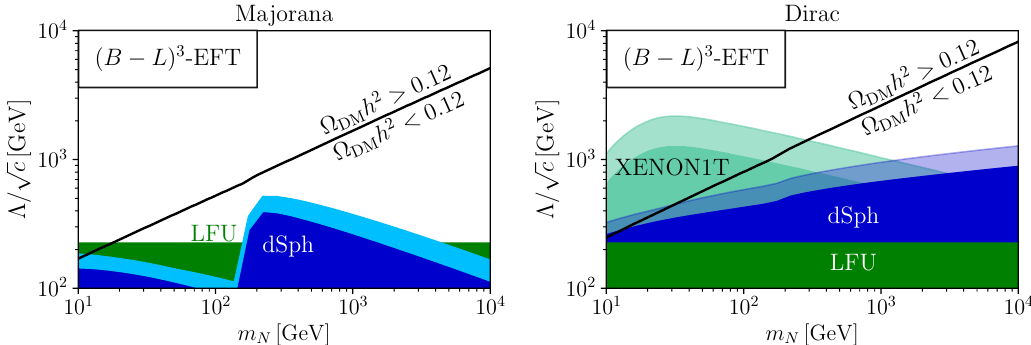
Figure 3: New-physics scale required by the relic abundance for the third gener- ation EFT scenario defined by Eq.(33) (black line) assuming Majorana (left) and Dirac (right) sterile neutrinos. Regions excluded by indirect detection from dwarf spheroidals are shown in blue. The light blue region corresponds to the variation of the J -factors within their 68% confidence bands. The bound from lepton flavor universality tests is shown in green. Direct detection limits from XENON1T (extrapo- lated between 1 TeV and 10 TeV) assuming 100 GeV < Λ < 10 TeV are shown in teal, the weaker bounds corresponding to Λ = 100 GeV. Direct and indirect detection h 2 = 0.12 constraints assume Ω DM